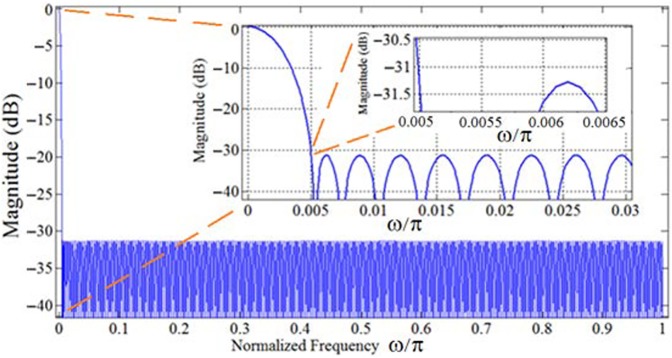
Magnitude response (dB) of the conventional implementation of UPartial(z).